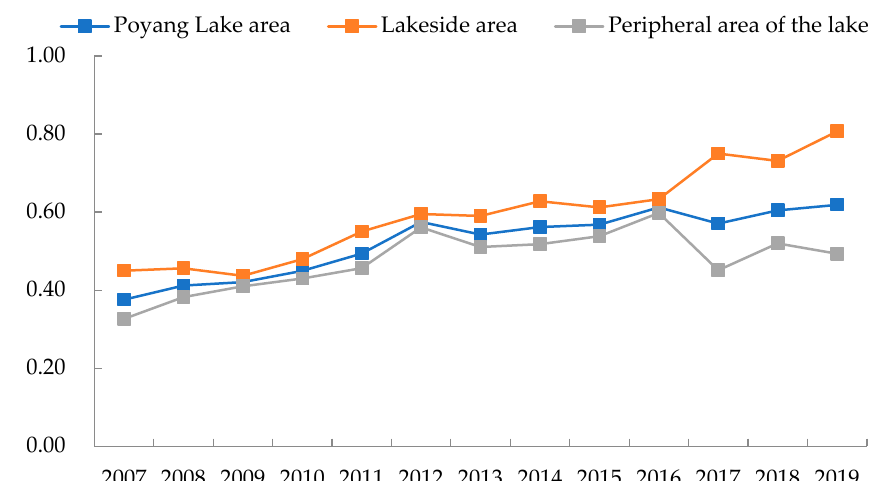
Figure 3. Time-series trends of EWP in the Poyang Lake area in the period of 2007–2019. EWP is still at a low level from the overall perspective despite its rapid improvement in the Poyang Lake area (Table 2). The average value of EWP in all seven basins of less than 1 fails to realize the relative effectiveness of DEA. The annual average value of EWP in the Raohe River basin reaches the maximum, with an average yearly growth rate of 5.619%, due to the progress of Guixi City and Wannian County in ecological civilization construction. By contrast, the level of well-being in the Fuhe River basin progressed slowly, with an annual average value of EWP of only 0.239. Table 2. Time series trend of EWP by county from 2007 to 2019.